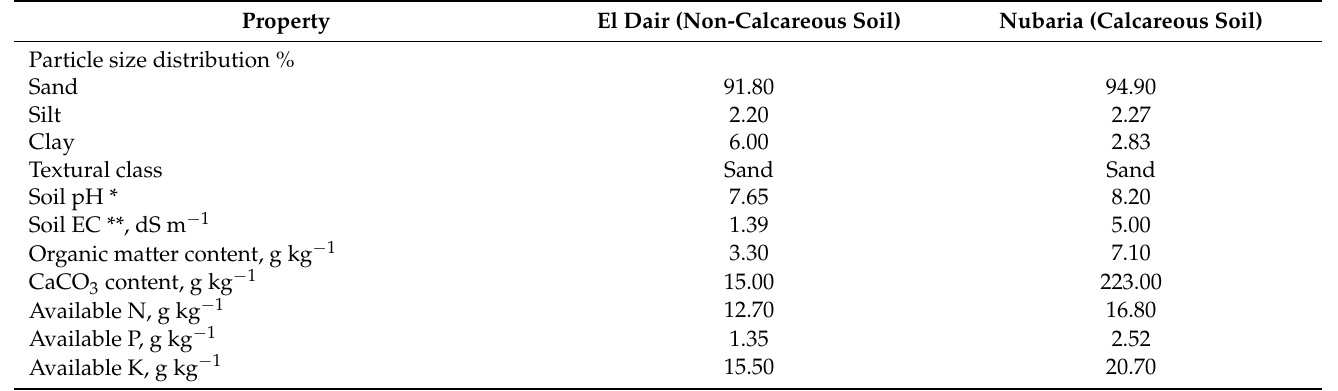
Table 1. Physical and chemical properties of the investigated soils.